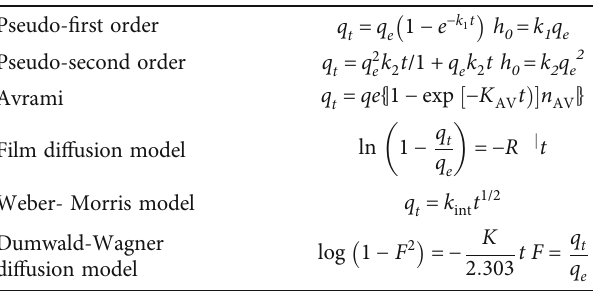
Table 3: Nonlinear modes of kinetic